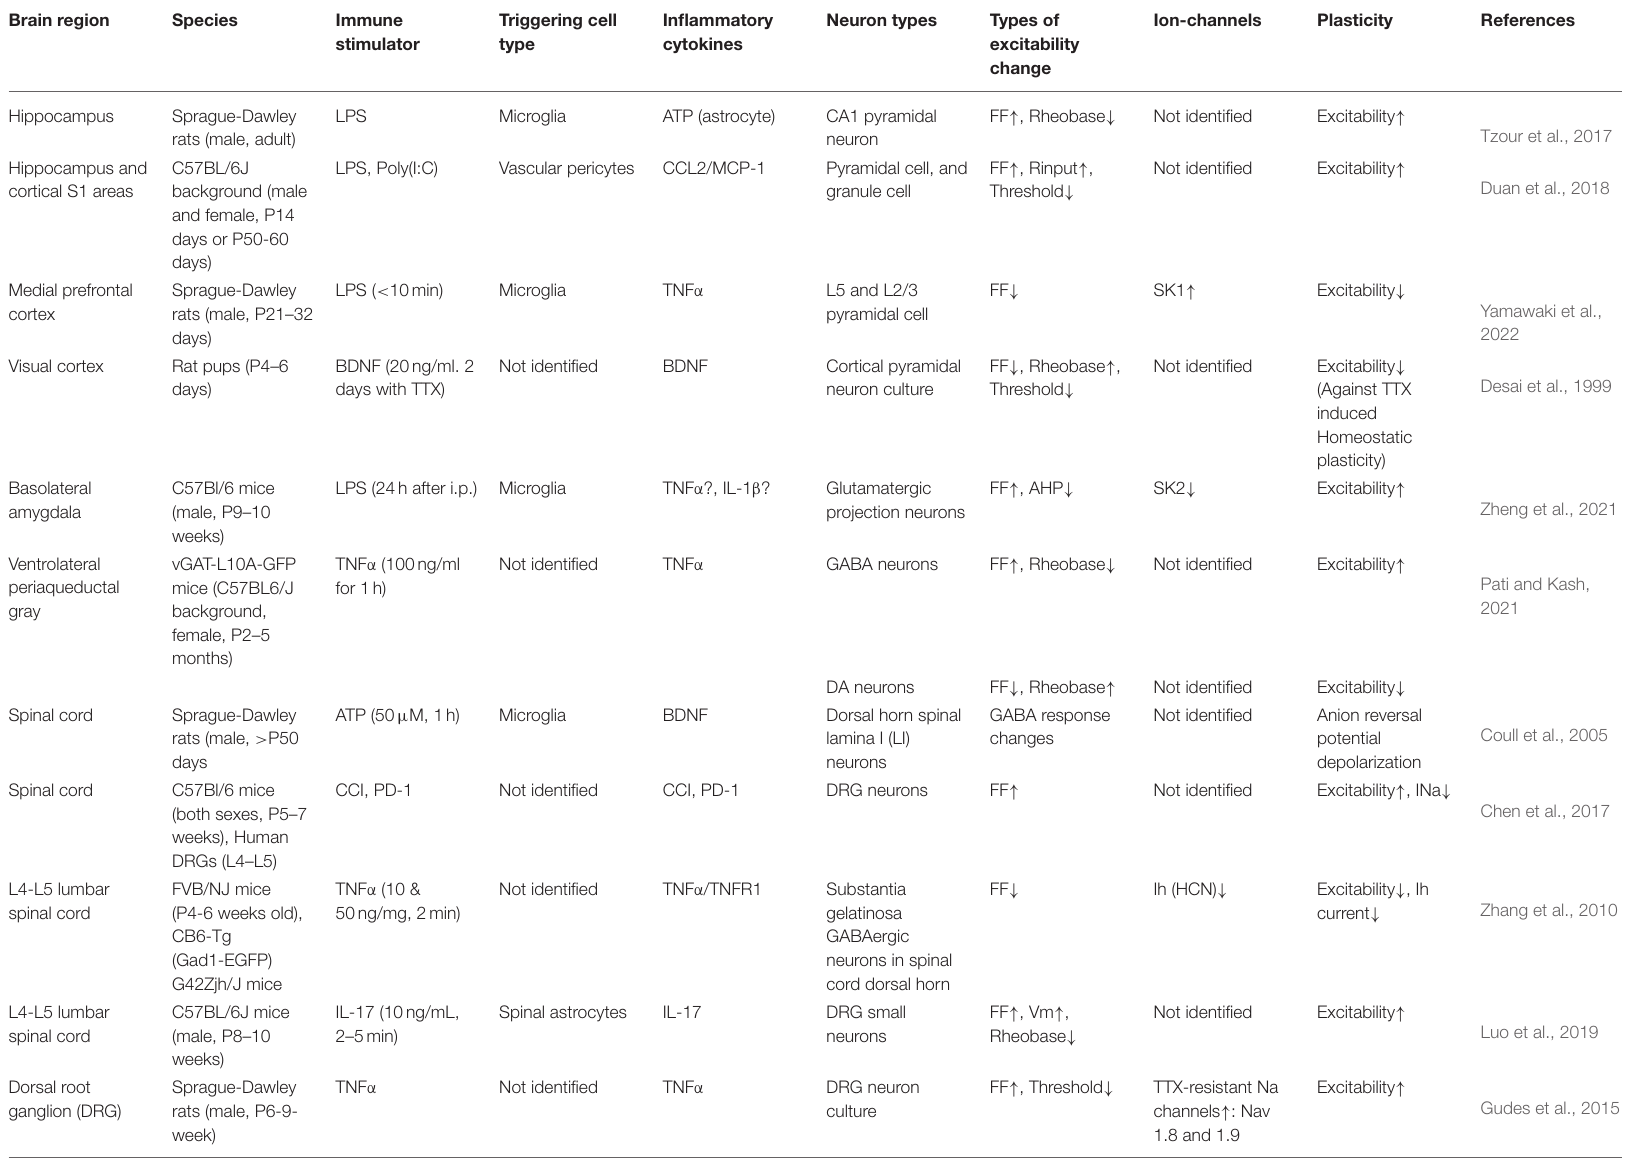
We tabulated a summary of the immune-triggered modulation of the intrinsic excitability of neurons in different brain regions. We categorized studies by brain region, animal species, stimulants for the immune cell, immune-cell or glia type, inflammatory mediators, neuron types, types of excitability changes, modulated ion-channels, and forms of plasticity of intrinsic excitability. The outcomes are indicated by different signs: increased ( ↑ ), reduced ( ↓ ), and unchanged. AHP, after hyperpolarization; FF, firing frequency; Rinput, input resistance; Vm, membrane